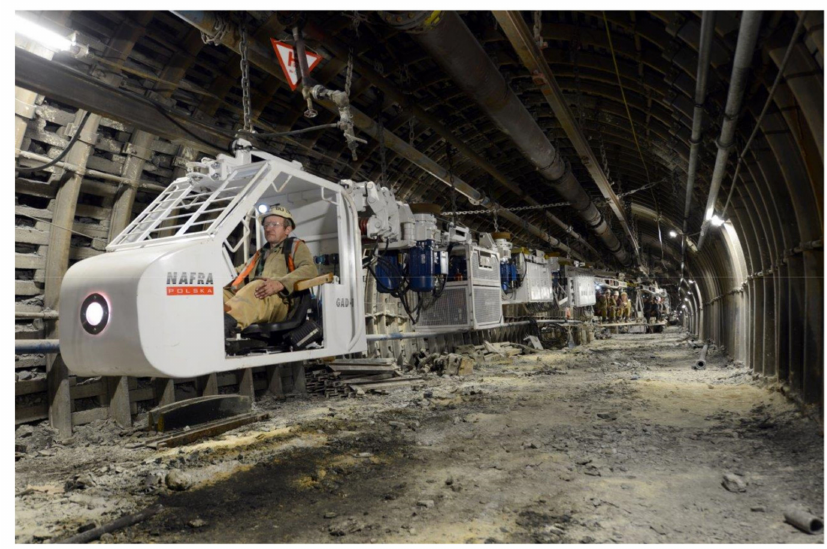
Figure 1. Suspended monorail transport system for mining